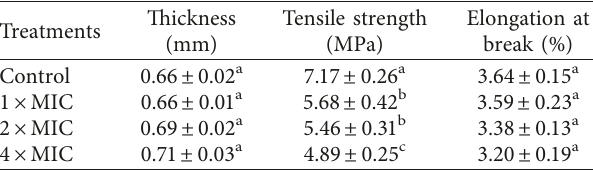
Table 1: Thickness, tensile strength, and elongation at break of the films incorporated without/with 1 × MIC, 2 × MIC, and 4 × MIC bifidocin